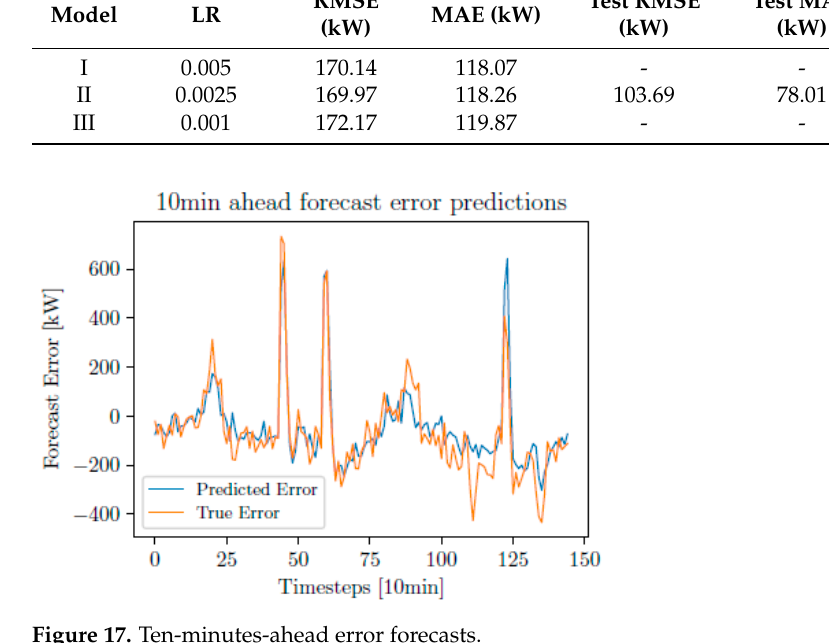
Table 7. Results of the 10-min-ahead error forecasting models.